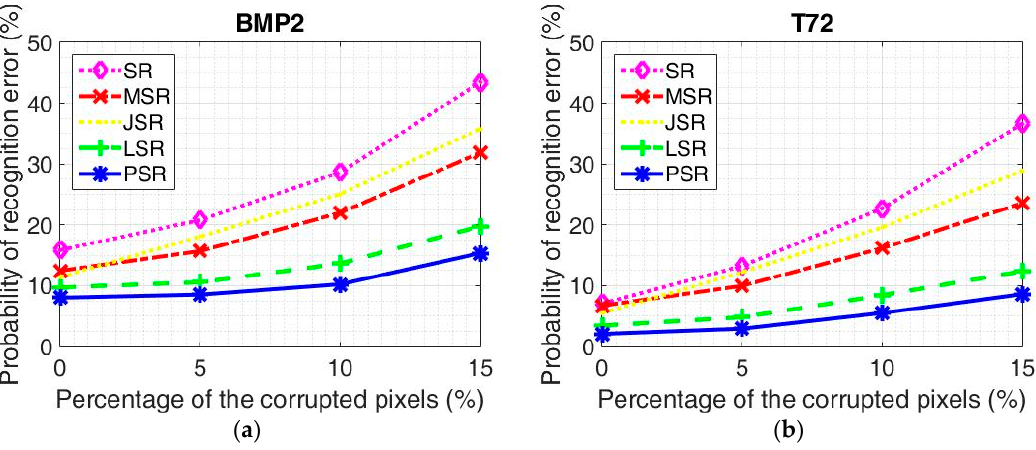
Figure 6. The probability of a recognition error under the different algorithms with different percentages of corruption. ( a ) BMP2 configurations; ( b ) T72 configurations.